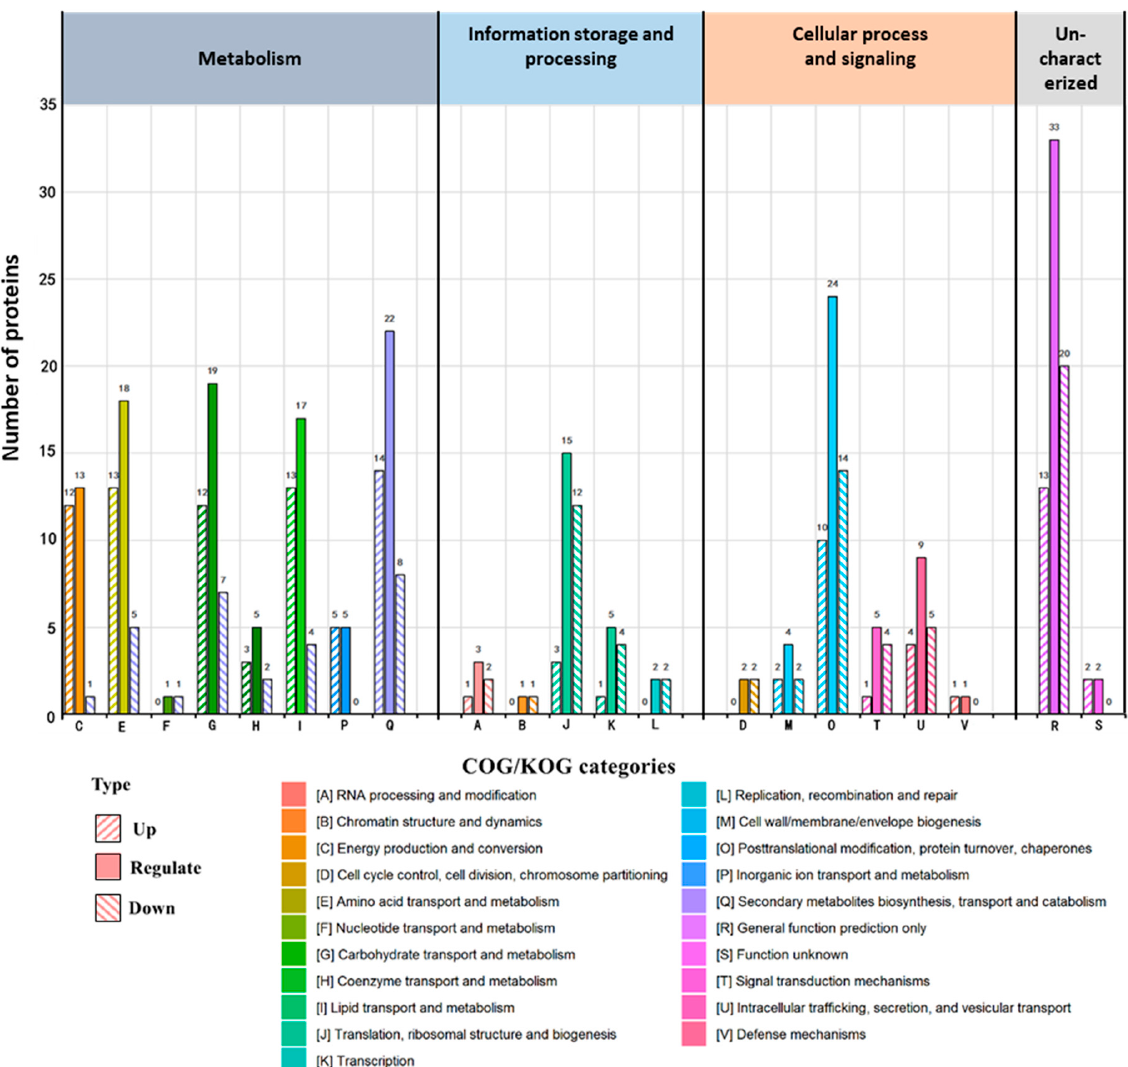
Figure 3. COG/KOG functional classification of differentially accumulated proteins grouped into 21 categories. The letters from A to V represent different categories according to the gene functions. Each category has three types of columns filled with solid colour and coloured slashes. The solid- colour-filled columns represent total regulated DAPs, and the coloured slash-filled columns represent up- and downregulated DAPs, respectively.